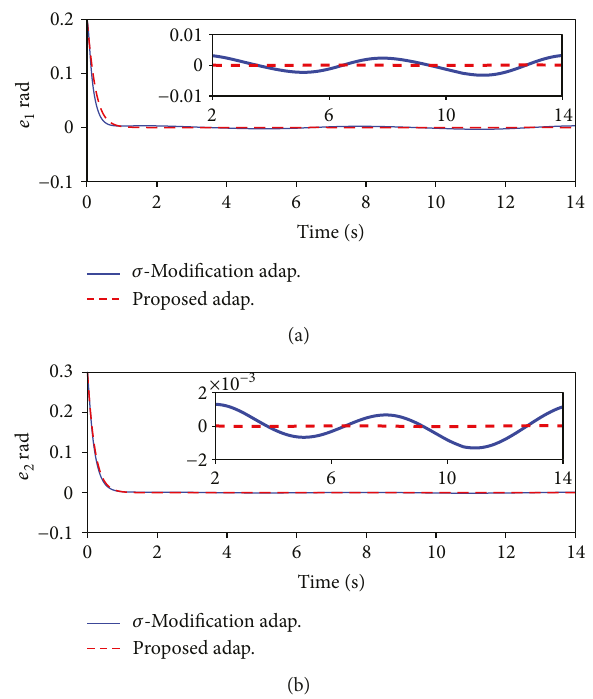
Figure 4: Tracking error of robotic joint position q